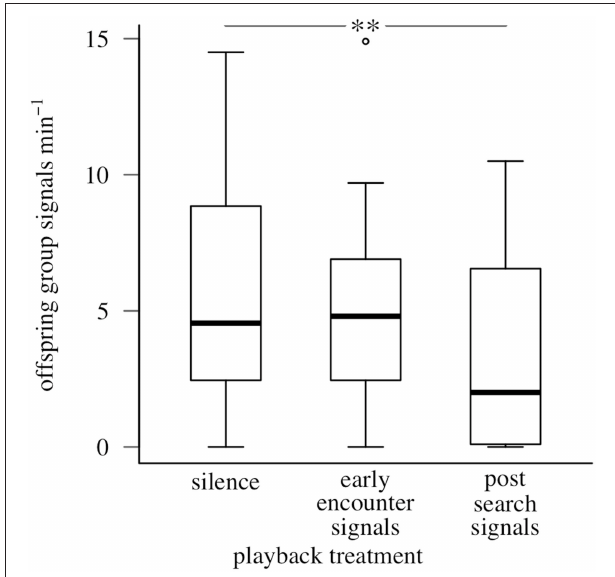
FIGURE 5 | Signaling responses of oak treehopper offspring aggregations to playback of silence, maternal early encounter signals, or post-search signals during simulated predator attacks (Experiment 2). Box plots show distributions of offspring group signaling rate (minimum, first quartile, median, third quartile, maximum; open circles represent outliers). N = 28 families. **represents P < 0.01, GLMM.